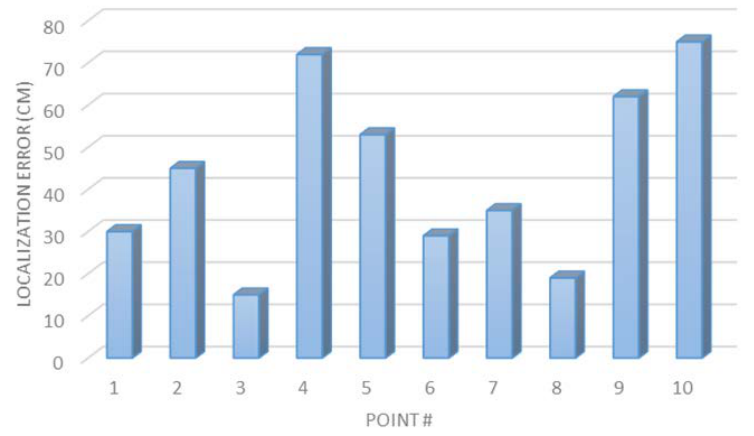
Figure 11. The localization error for the robot system in Area 1 for 10 different positions.